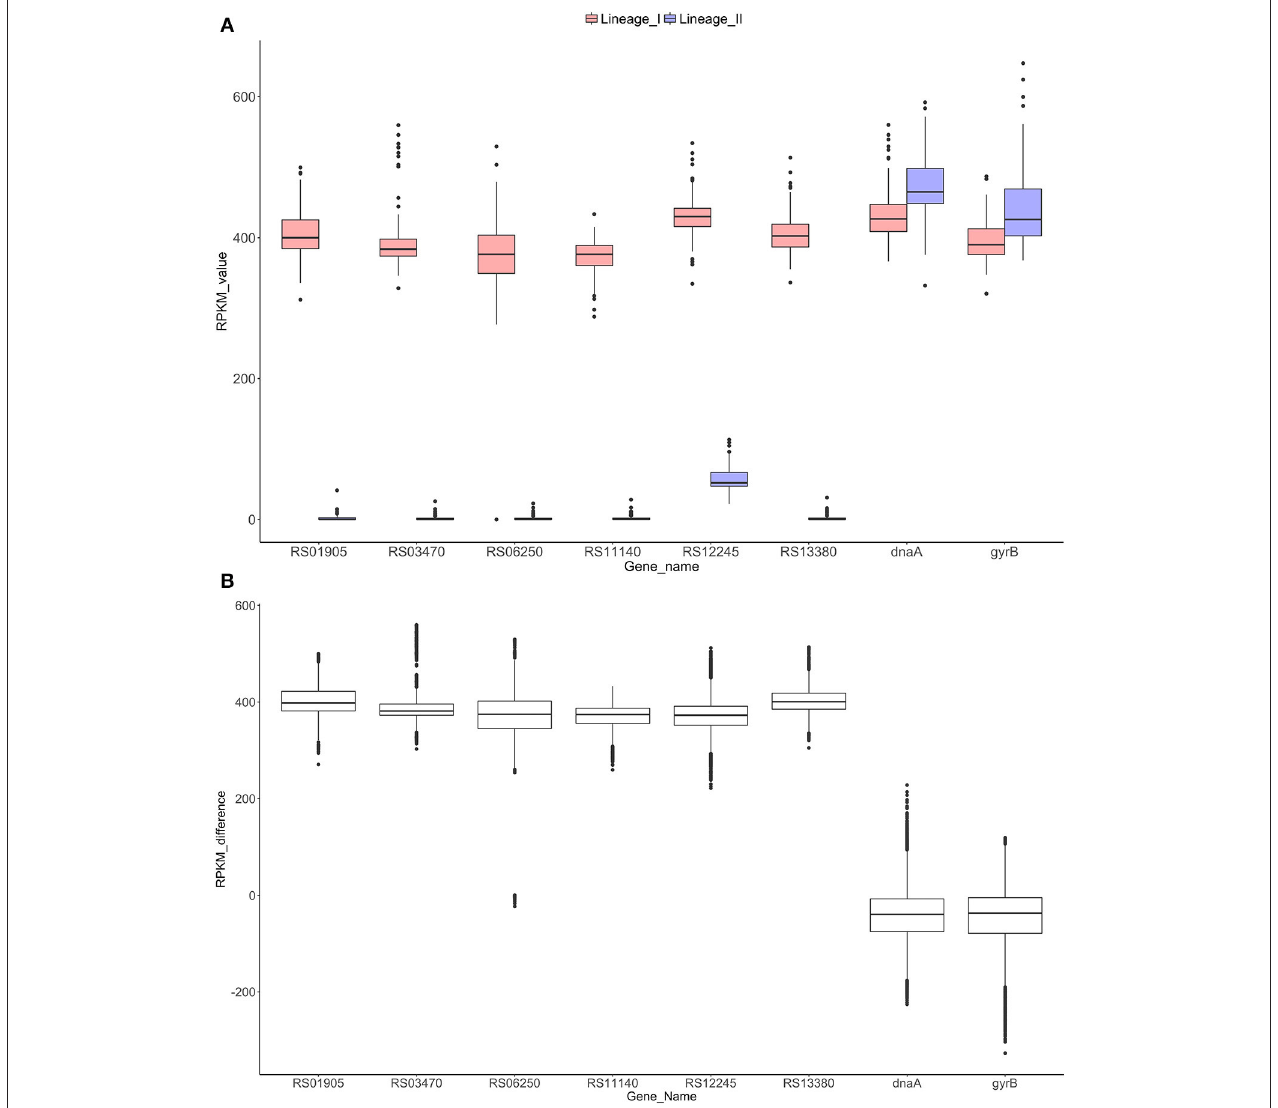
FIGURE 4 | RPKM analyses to check the absence/presence of the selected genes in both lineages (A) . Distribution of the RPKM values in both lineages for the six selected genes and the control genes dnaA and gyrB . All the differences were significant for a p -value of 0.0001 (Mann-Whitney-Wilcoxon test). Gene RS12245 is affected by an artifact when counting reads in lineage II due to border effect (data not shown). (B) Distribution of the RPKM-differences between lineages I and II for each gene. Significant differences were found among the control groups and the six genes ( p -value < 0.0001, Dunn’s